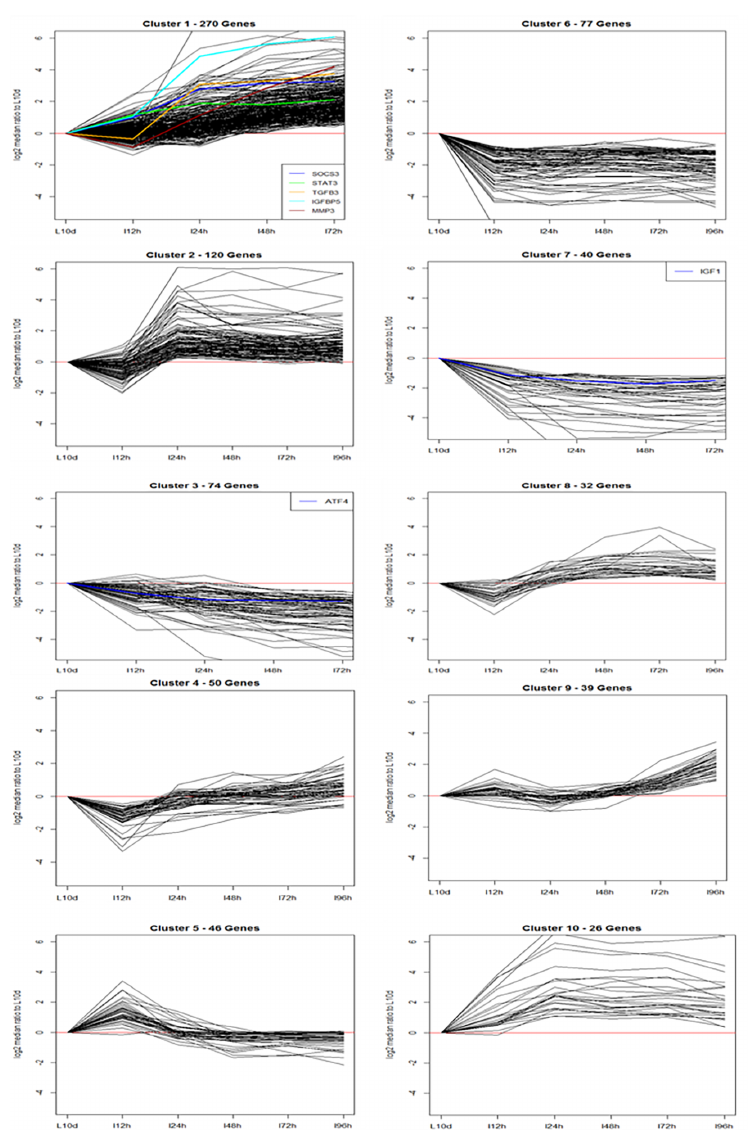
Fig 2. The log2 fold change in gene expression profiles for the ten significant clusters identified through the STEM Clustering. Y-axis represents the relative gene expression levels of involution days 0.5, 1, 2, 3 and 4 days compared lactation day 10 in log base 2 scale. X-axis represents the time points (L10, lactation day 10; I12h, involution day 0.5; I24h, involution day 1; I48h, involution day 2; I72h, involution day 3; I96h, involution day 4). SOCS3, suppressor of cytokine signaling 3; IGF1, insulin-like growth factor 1 (somatomedin C); STAT3, signal transducer and activator of transcription 3 (acute-phase response factor); TGFB3, transforming growth factor, beta 3; ATF4, activating transcription factor 4; IGFBP5, insulin-like growth factor binding protein 5; MMP3, matrix metallopeptidase 3. GSEA results of involution-specific signatures in IBC versus non-IBC normals. Unfor- tunately there are not additional samples from which to validate the findings beyond the report above. Nevertheless, we speculated that the relevant signatures might be expressed in gene expression data from histopathologically normal breast isolated from IBC (N = 19) and non- IBC (N = 25) mastectomy patients given our hypothesis that the unique normal tissue changes influence the symptoms of IBC.